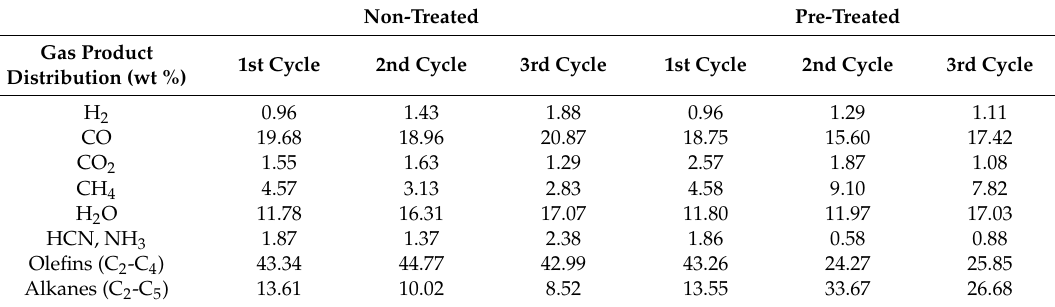
Table 4. Gas product distributions with catalyst regeneration cycles.